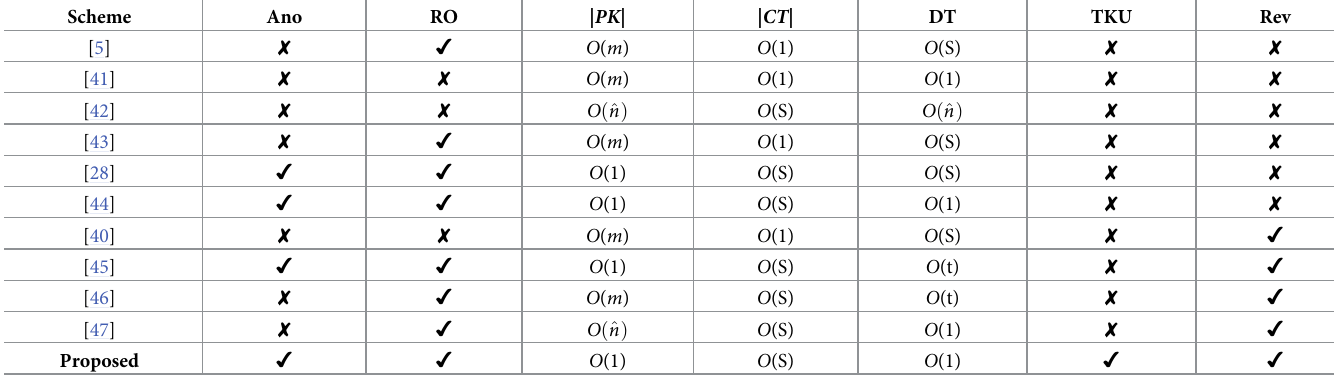
Table 2. Comparison of various IBBE schemes.